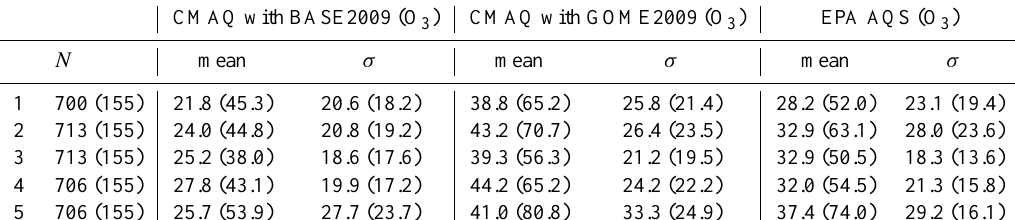
Table 4. The total number, the mean, and the standard deviation of the EPA AQS O 3 observations (inppbv), CMAQ O 3 simulations with the baseline emissions, BASE2009 and CMAQ O 3 simulations with GOME-2 adjusted emissions, GOME2009 at the five EPA AQS O 3 measurement sites (see the right panel of Fig. 3, 1: Los Angeles, 2: South Pasadena, 3: Anaheim, 4: La Habra, and 5: Riverside). The parentheses indicate the corresponding data during the daytime (13:00–17:00LT). CMAQ with BASE2009 (O 3 )